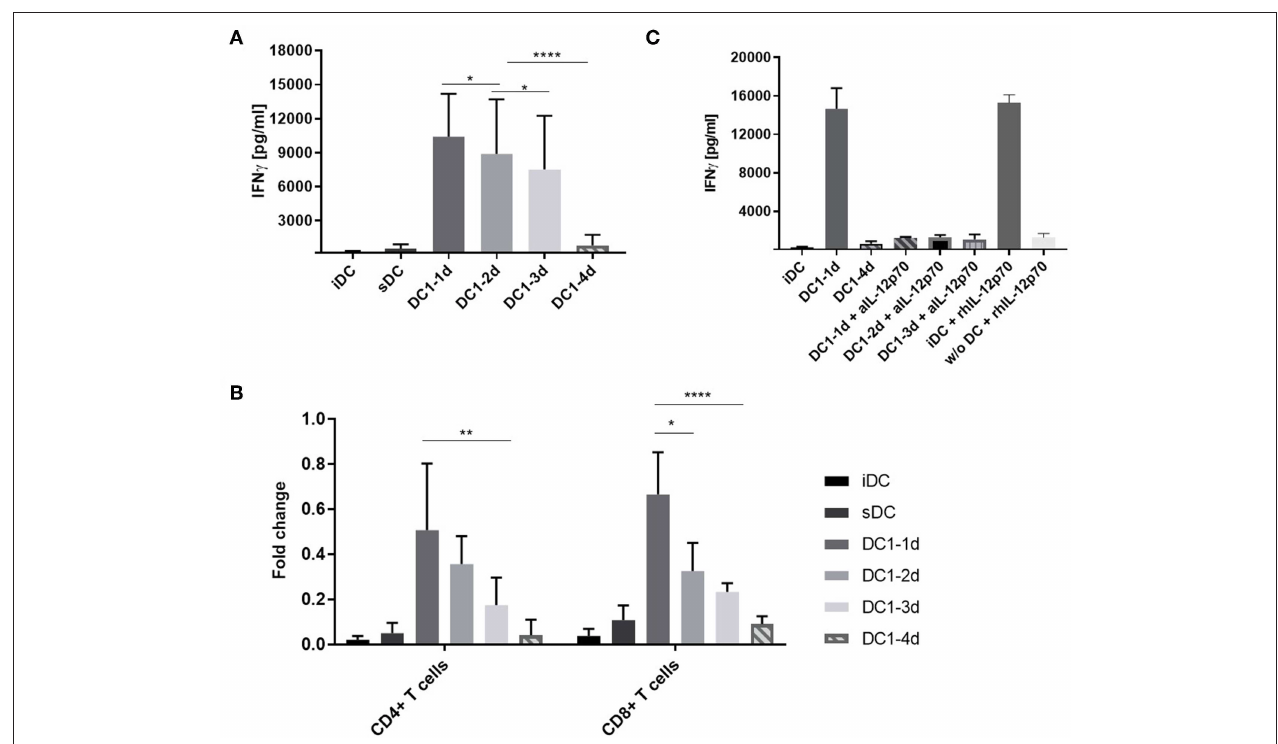
FIGURE 3 | IFN γ release from co-cultures with long-term activated DCs is reduced. (A) DCs were activated with the DC1 maturation cocktail (LPS and IFN γ ) for 1, 2, 3, or 4 days (DC1-1d, DC1-2d, DC1-3d, DC1-4d) prior to being set up in co-culture with allogeneic PBMCs at a 1:10 ratio. After 5 days, IFN γ release was measured in the MLR supernatants with a lower limit of sensitivity of 156 pg/mL. Co-cultures with iDCs and sDC were included for comparison. Cumulative data are shown from five independent experiments with nine unique donor pairs in total ( n = 9), consisting of seven DC donors and five PBMC donors. All experiments were performed in quadruplicates. Bars represent mean + standard deviation. Two-way ANOVA with Tukey’s post-hoc test was performed on log10-transformed data to compare DC1 groups (**** p ≤ 0.0001, ** p ≤ 0.01, * p ≤ 0.05, and ns, not statistically significant). (B) Same as (A) , except isolated CD4 + and CD8 + T cells were used as responder cells instead of PBMCs. Data from three donors ( n = 3) are normalized to highest value of IFN γ release within each donor. Bars represent mean + standard deviation. Two-way ANOVA with Tukey’s post-hoc test was performed on normalized data to compare DC1 groups (**** p ≤ 0.0001, ** p ≤ 0.01, * p ≤ 0.05). The lower limit of IFN γ detection was 39 pg/mL. (C) Co-cultures were set up as in (A) and supplemented with anti-IL-12p70 or recombinant human IL-12p70. Recombinant human IL-12p70 was also added to cultures of PBMCs without DCs (w/o DC). After 5 days, IFN γ release was measured. Cumulative data are shown from one experiment with three unique donors ( n = 3). Bars represent mean + standard